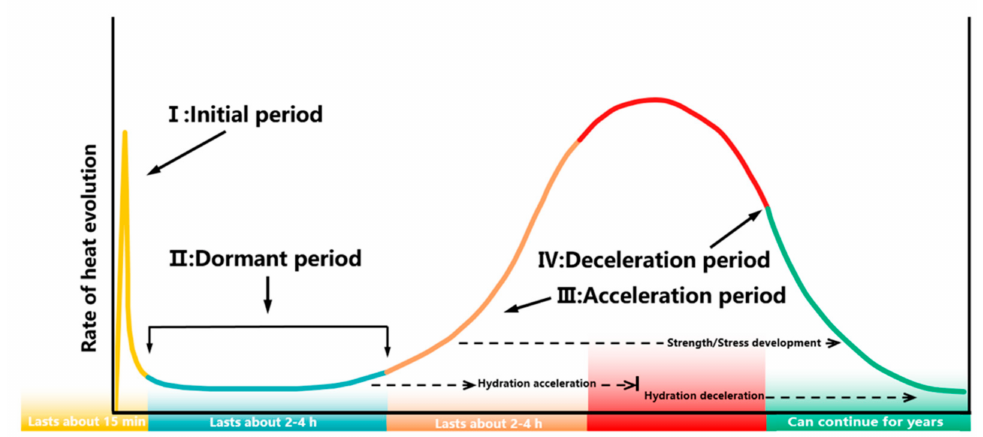
Figure 2. Hydration process of C 3 S and